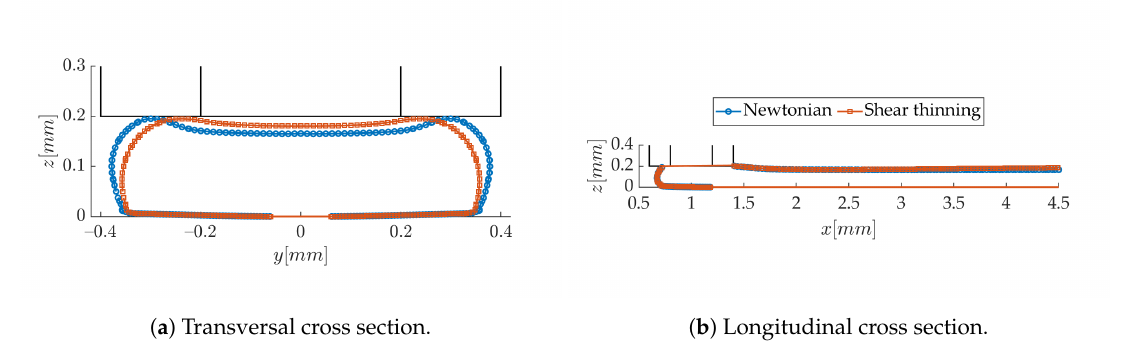
Figure 13. Effect of non-newtonian behavior on the strand shape ( h / d = 0.5, V / U =